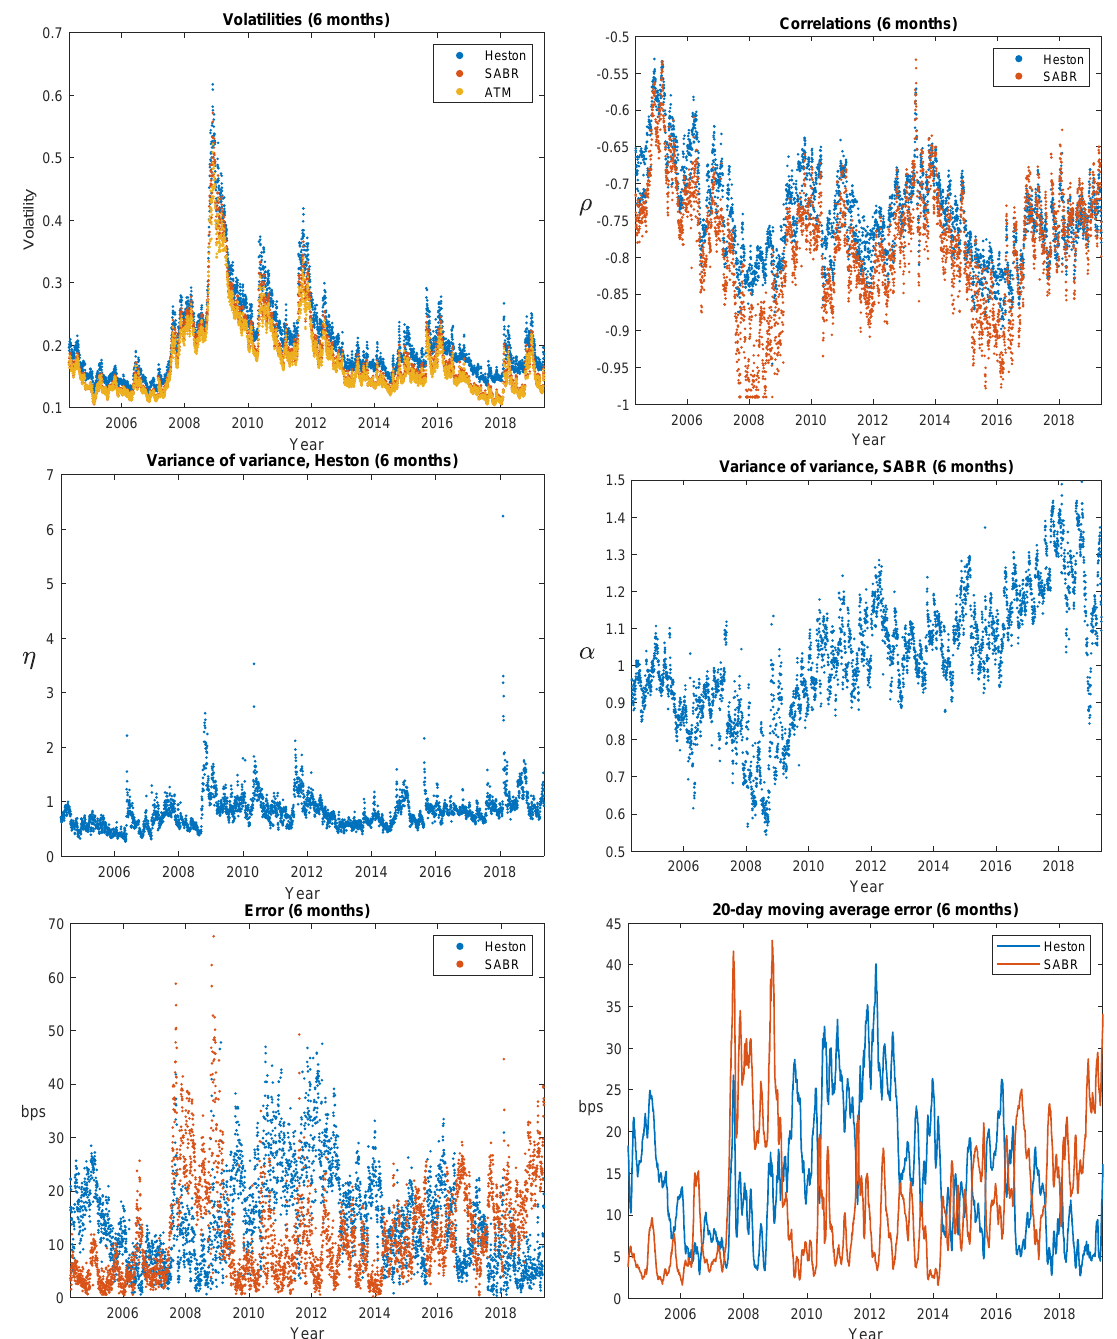
Figure 4. Calibration to the 6 month